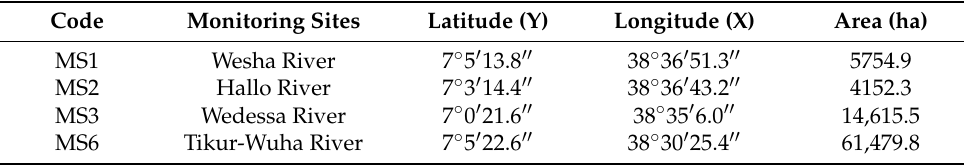
Table 1. Monitoring stations from rivers in Lake Hawassa Watershed.